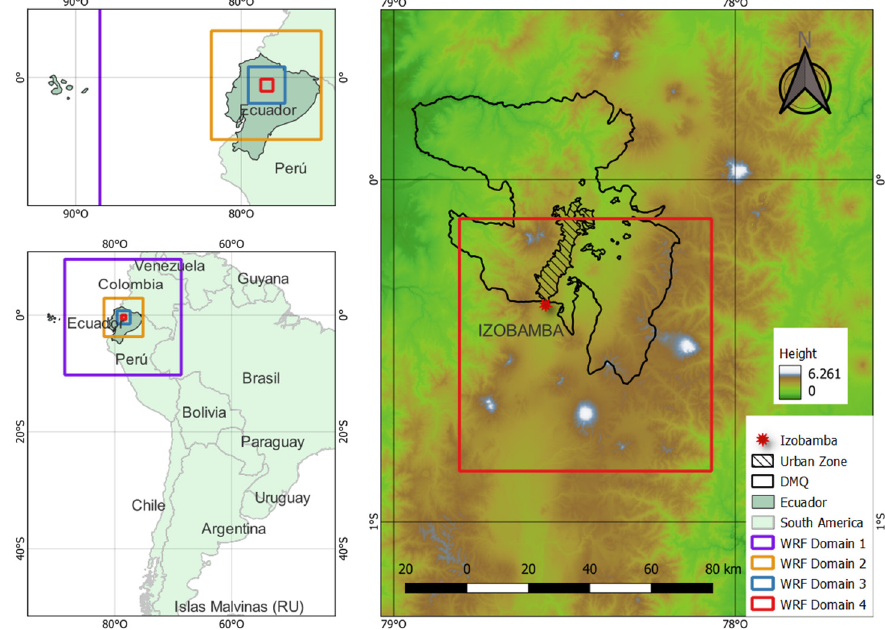
Figure 1. Location of Izobamba station near the capital of Ecuador, Quito (DMQ).